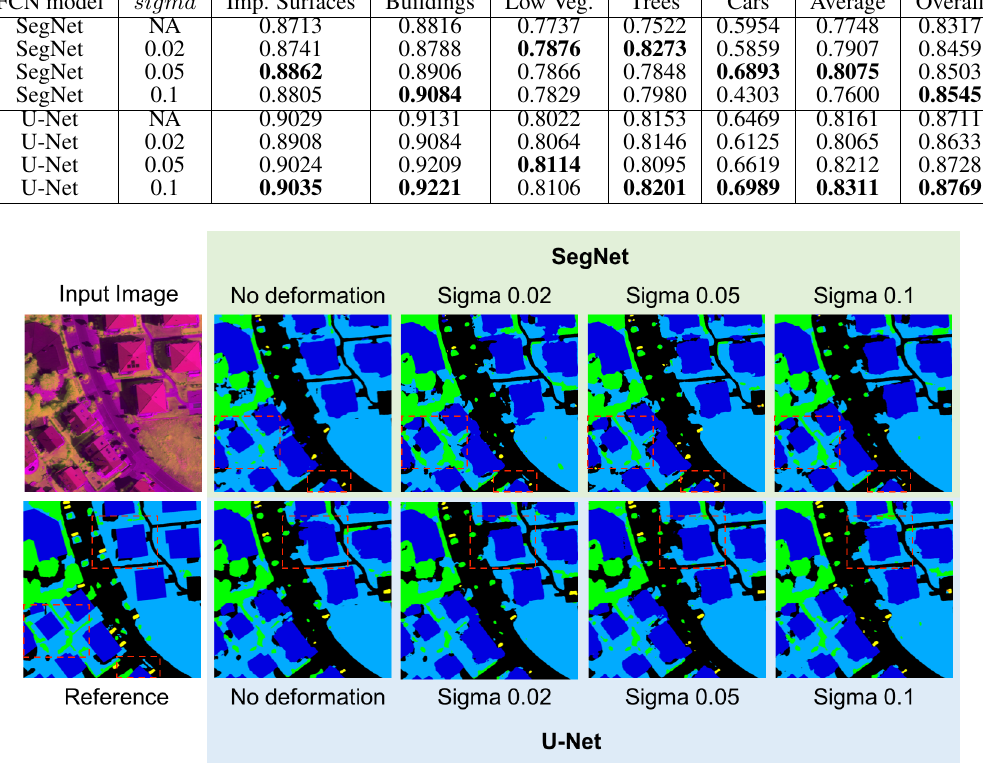
Figure 5. Visual outcome of our experiments. Buildings are observed in dark blue, impervious surfaces in black, low vegetation in light blue, cars in yellow and trees in dark blue. It is possible to visually attest the impact of our data augmentation method in both architectures, while U-Net performs better than SegNet. One can also notice that increasing sigma usually leads to better